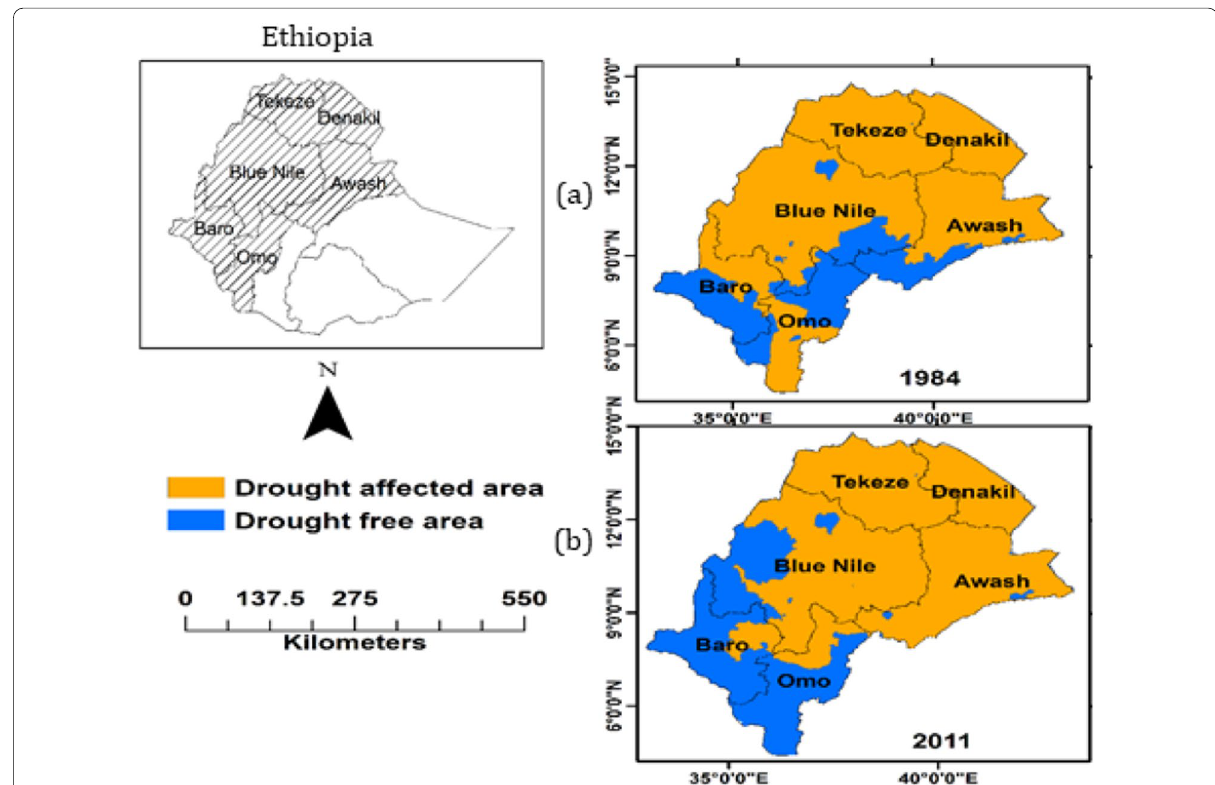
Fig. 5 Spatial pattern of the RHD in the selected river basins during ( a ) 1984 and ( b ) 2011. (Data source: www. emdat. be, developed from Table